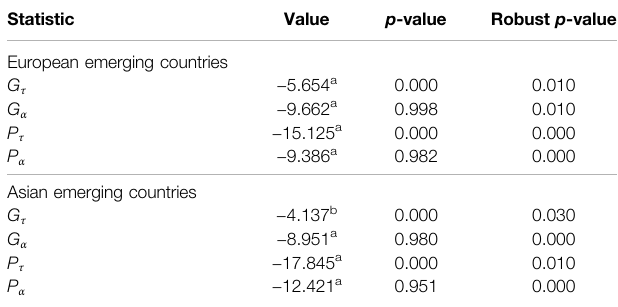
TABLE 2 | CIPS panel unit root test results Variable